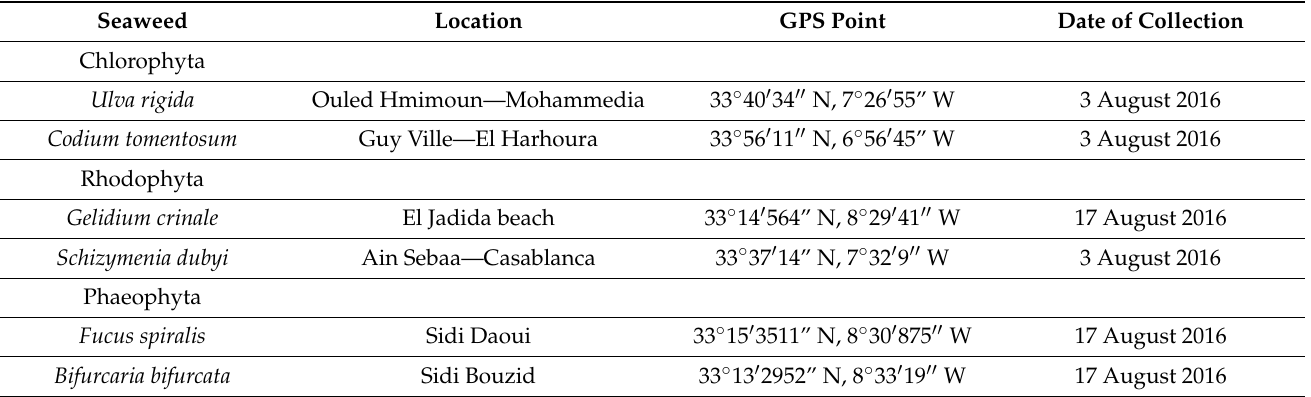
Table 1. Collection site locations of the 6 studied seaweeds.